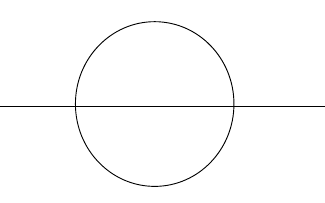
Figure 1 . Melonic diagram contributing to the 2-point function in a tensor model theory with three indexes and quartic